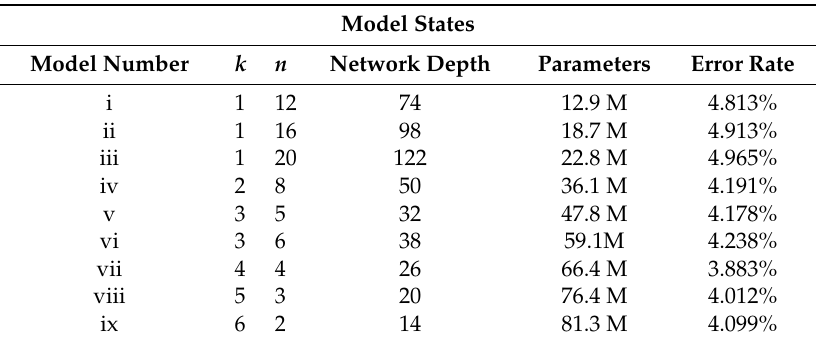
Table 3. The error rate of test set under different network structures, where k is the scaling parameter and n is the number of learning modules.